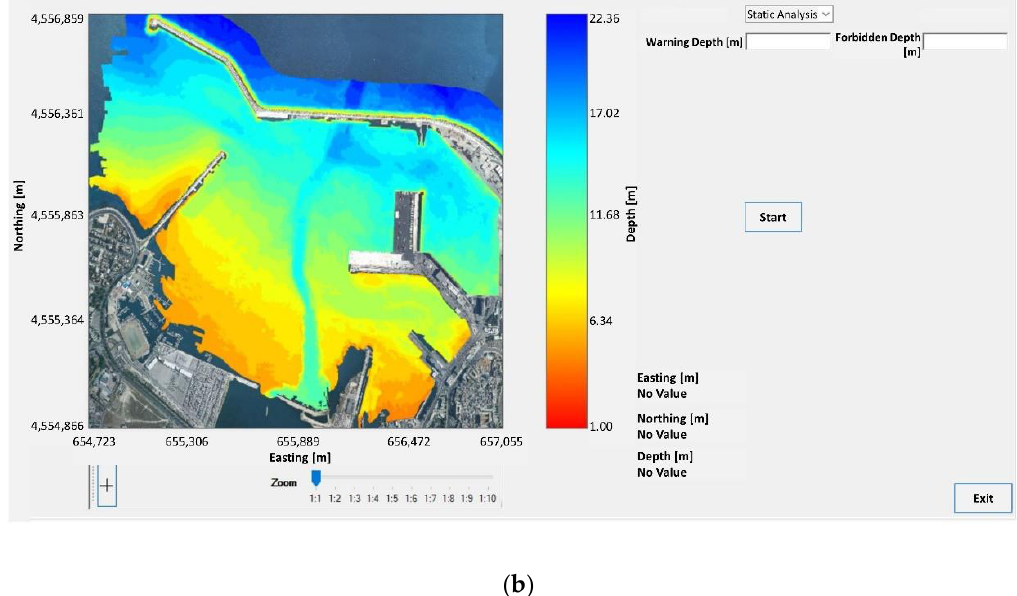
Figure 2. Bathymetric maps of test sites: ( a ) port of Livorno; ( b ) port of Bari; data have been provided by local Port Au- thorities.